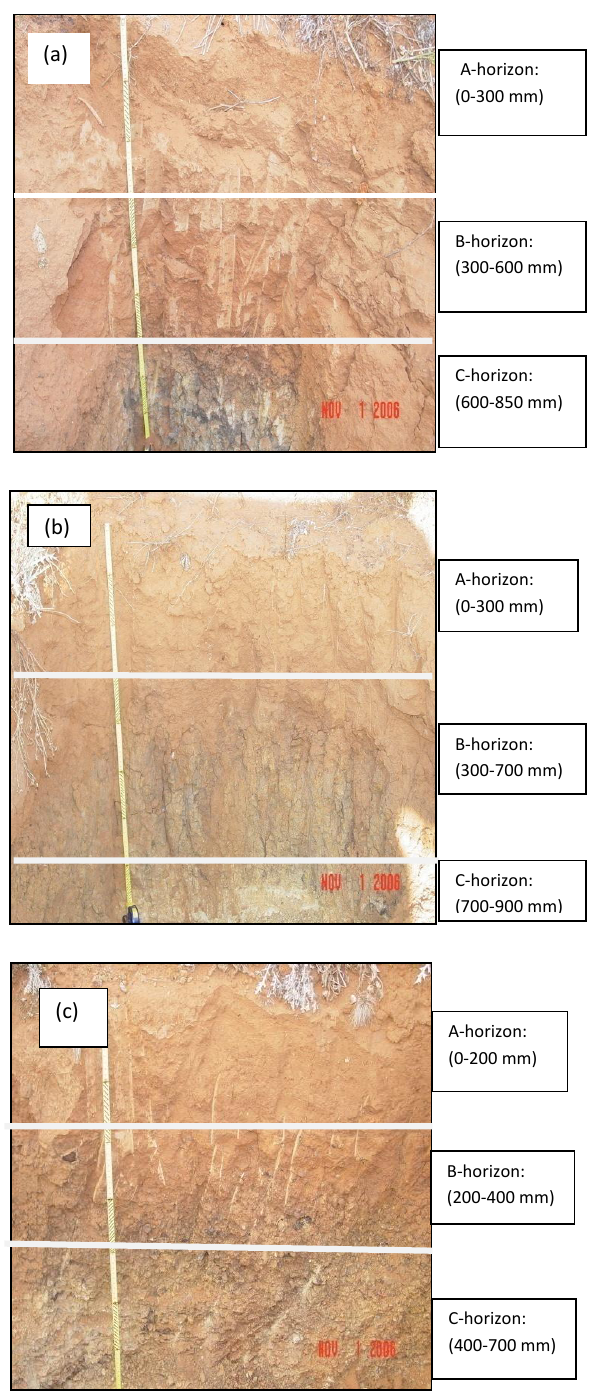
Figure 1 Profile of the Tukulu (a), Sepane (b) and Swartland (c) soil type Fig. 1. Profile of the Tukulu (a) , Sepane (b) and Swartland (c) soil